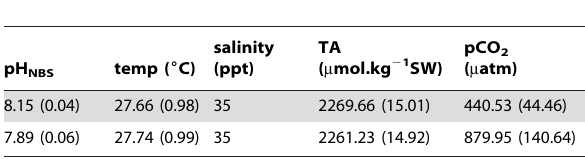
Table 1. Mean ( 6 SD) seawater parameters in the experimental